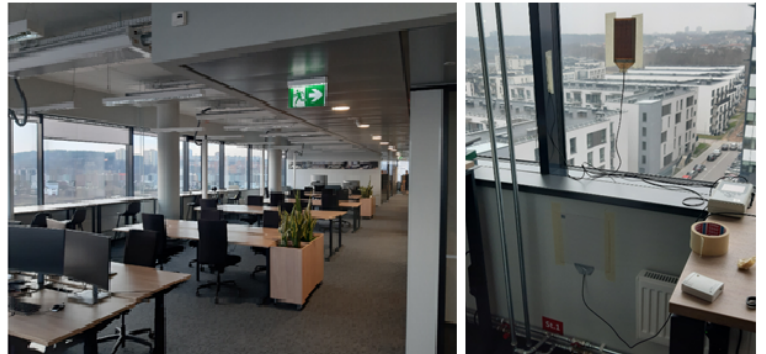
Figure 2. Measured space of the